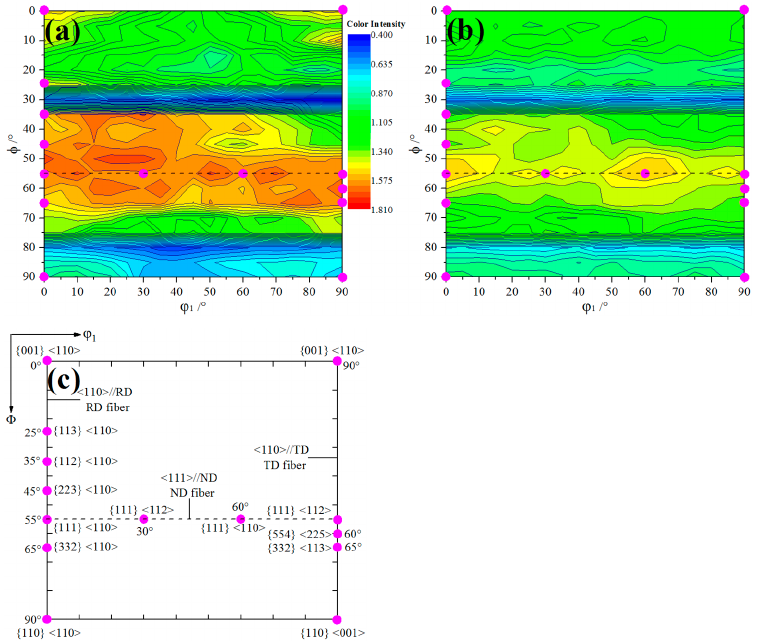
Figure 9. ODF sections ( ϕ 2 = 45°) of different C content: ( a ) ELC, ( b ) LC, ( c ) the important orientation positions.